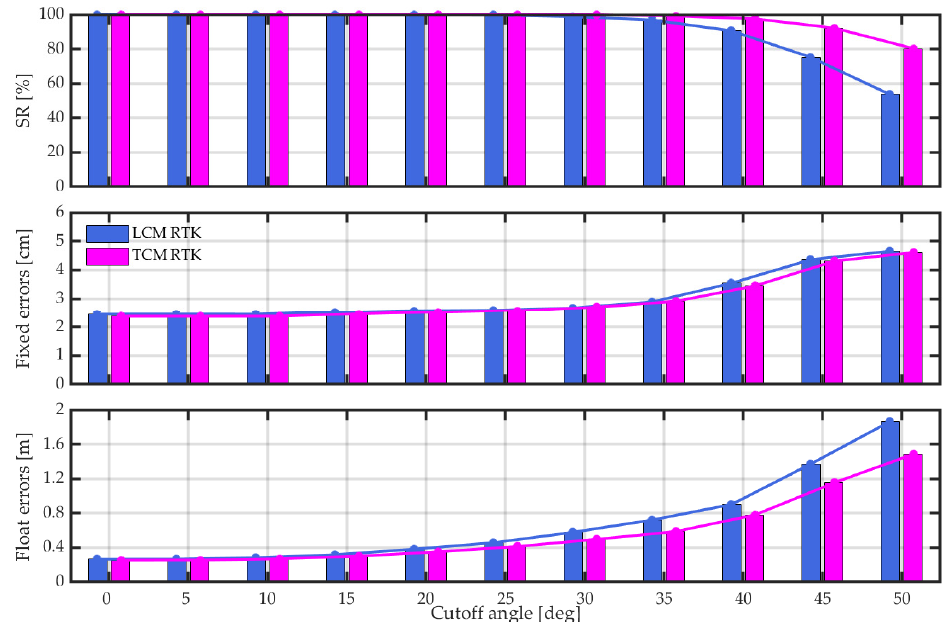
Figure 10. Success rate (SR) (top), three-dimensional errors of the correctly fixed solution and the float solution of LCM and TCM RTK positioning on DOY 120, 2021 for the baseline GODE-USN7 with different cutoff elevation angles ranging from 0 to 50°. The bars and lines denote the corresponding statistics. Table 5. The SR, accuracy of both the correctly fixed and float solutions of LCM and TCM RTK, and the corresponding improvement in TCM RTK with respect to LCM RTK.